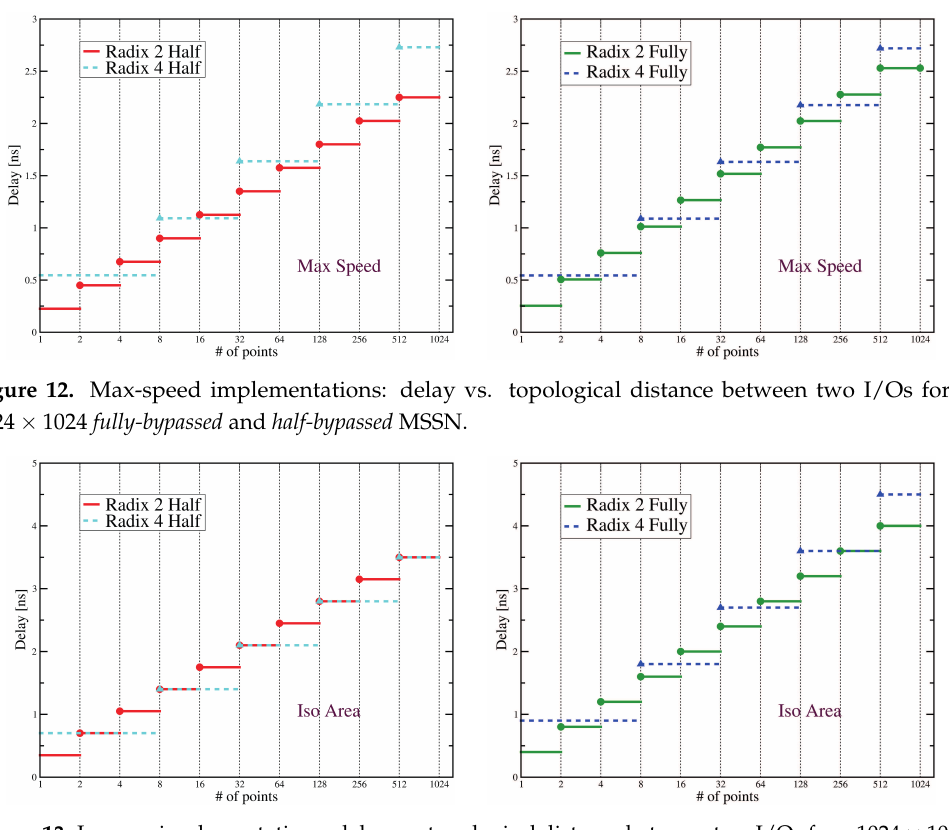
Figure 13. Iso-area implementations: delay vs. topological distance between two I/Os for a 1024 × 1024 fully-bypassed and half-bypassed